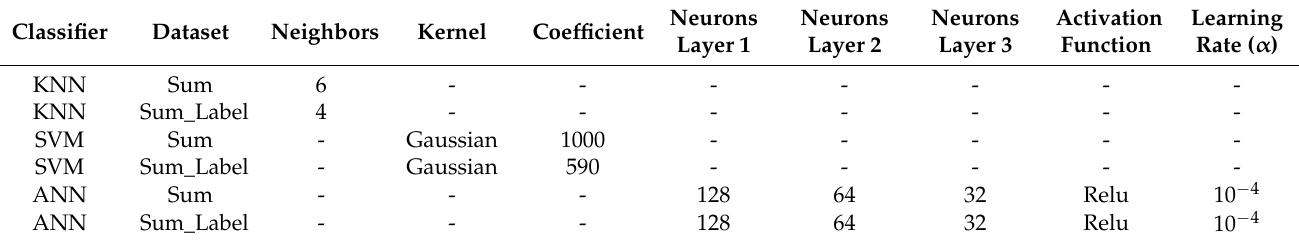
Table 6. The optimal configurations of k-NN, SVM and ANN classifiers for adding a sex labeling obtained from the validation